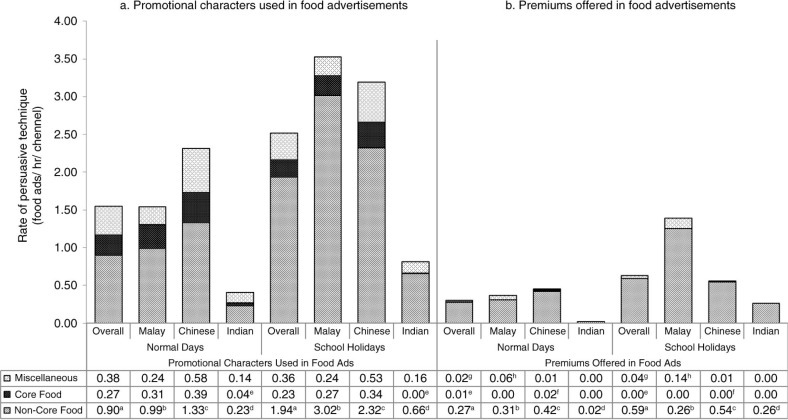
Persuasive techniques as per seasonal variation and TV channel ethnicity. (a) Promotional characters used in food advertisements. (b) Premiums offered in food advertisements. For ethnic-specific popular channels, three popular channels were for Malay whilst five popular channels were Chinese and four popular channels were Indian. One TV channel was common to both Malay and Indian viewership. Hence, overall analysis was carried out based on only 11 channels. Within each figure, values sharing same superscripts are significantly different between normal days and school holidays.